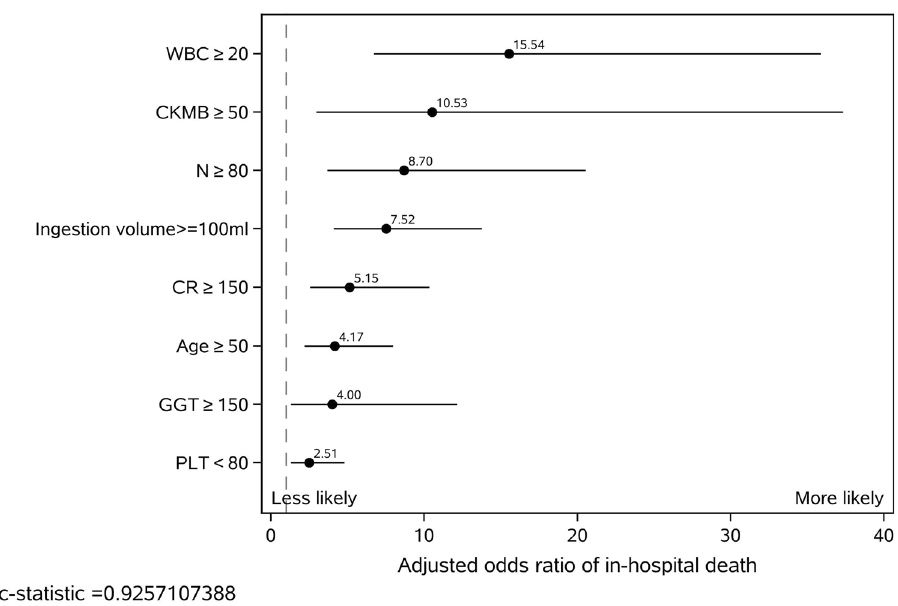
Figure 2. Risk factors associated with in-hospital death based on the training sample. Eight candidate factors, including age, ingestion volume, CK-MB, PLT, WBC, N, GGT, and Cr, were identified using the MCMC simulation. Factors with a posterior probability > 0.95 were considered significant for predicting the